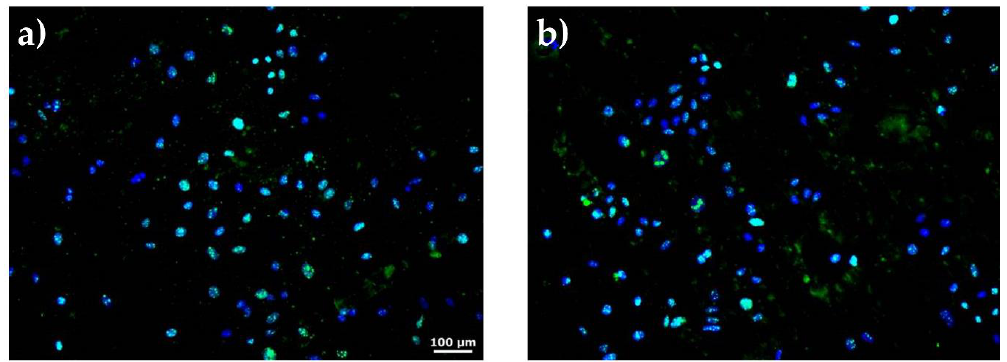
Figure 13. Fluorescence microscopy images of SaOs2 cells labeled with Ki67 and DAPI after cultivation on BGN/PMMA/SS ( a ) and SS ( b ) samples. 100X magnification. As visible from Figure 14, osteoblasts seeded on BGN/PMMA/SS films proliferated in a larger proportion (86%), superior to cells in the control experiment (71.1%) or SS samples (66.1%).